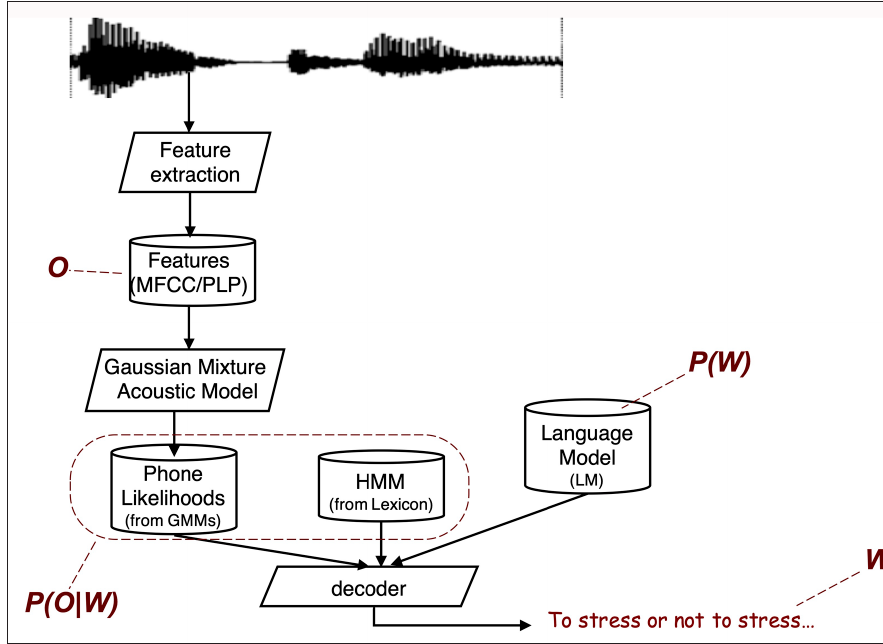
Figure 1: General architecture of an ASR